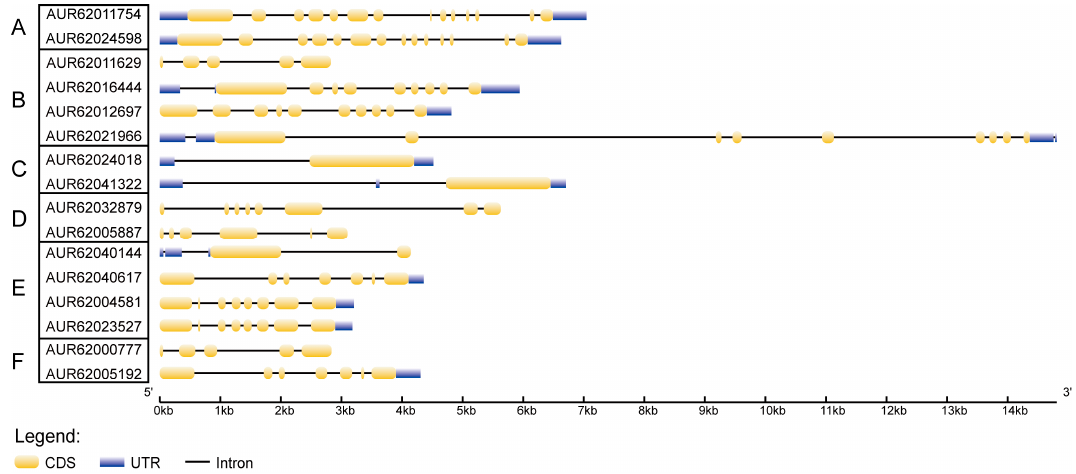
Figure 4. Conservation and diversity of gene structures of the Hsp70 paralogous pairs in quinoa . This figure shows a schematic representation of gene structures of Hsp70s in quinoa. The yellow boxes represent exons, black lines represent introns and blue boxes represent untranslated region (UTR) region. The HSP70 Clades A–F ( A – F ) are indicated on the left. Scale bar indicates number of base pair (bp).